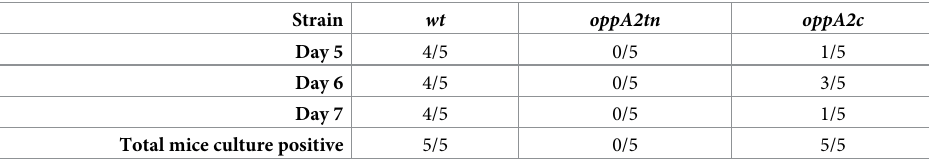
Table 4. oppA2tn positive blood culture